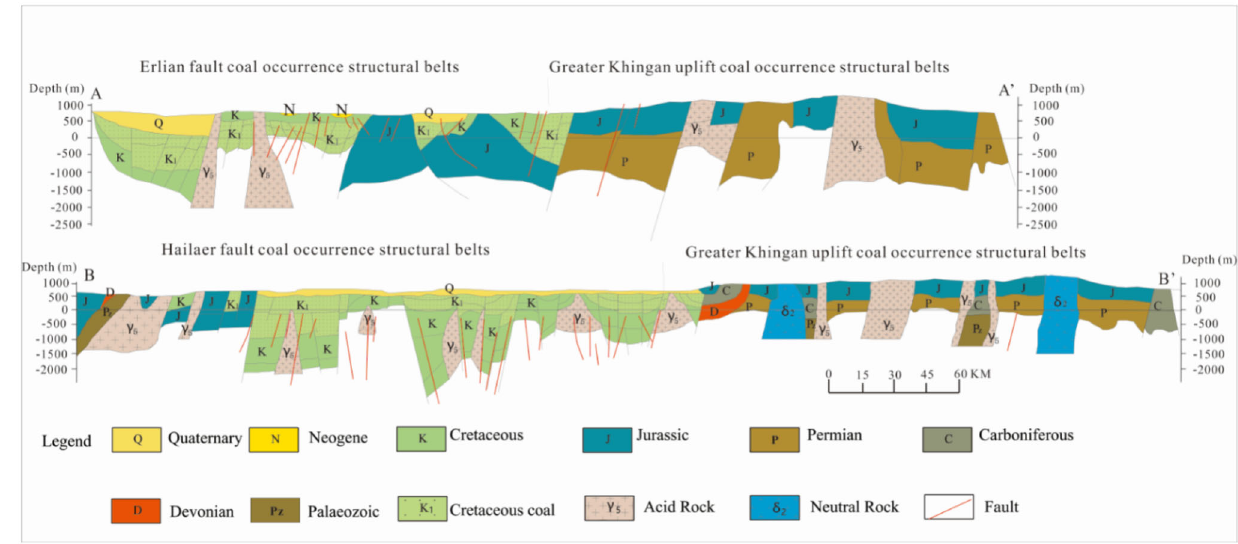
Fig. 4 Structural profile of the western subarea in the Northeast China coal occurrence structural area (section position see Fig.